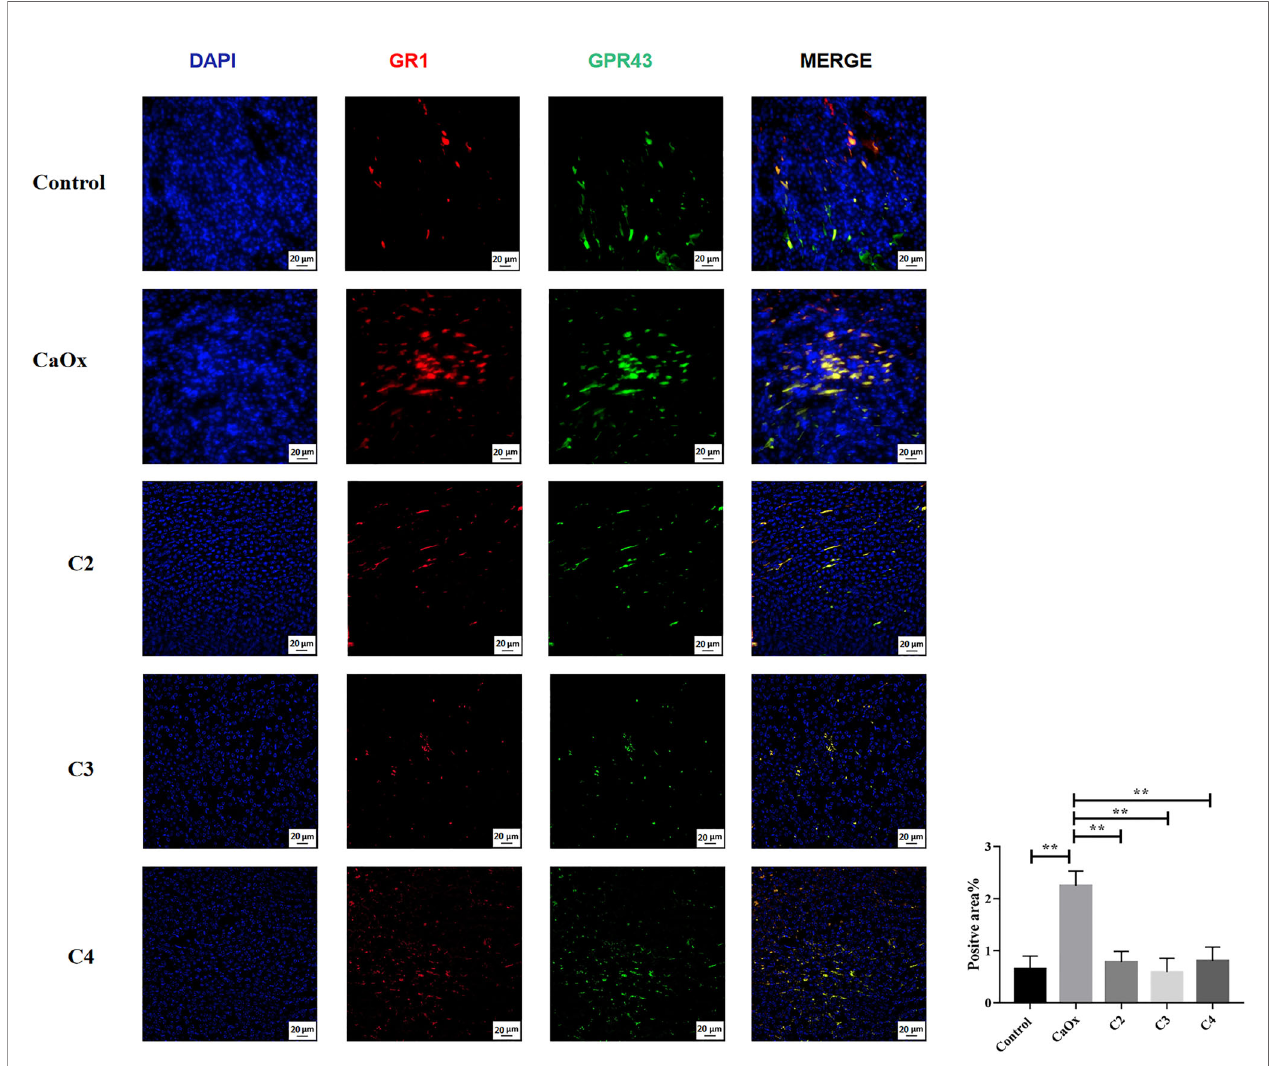
FIGURE 11 | Representative images of immuno fl uorescence staining of neutrophils in kidney of controls, CaOx mice and CaOx mice administration of SCFAs. 594 (GR1, red), and FITC (GPR43, green) fl uorescence images and merged images with DAPI staining (blue) of the same sections are also shown. Statistically signi fifi cant was shown as **p